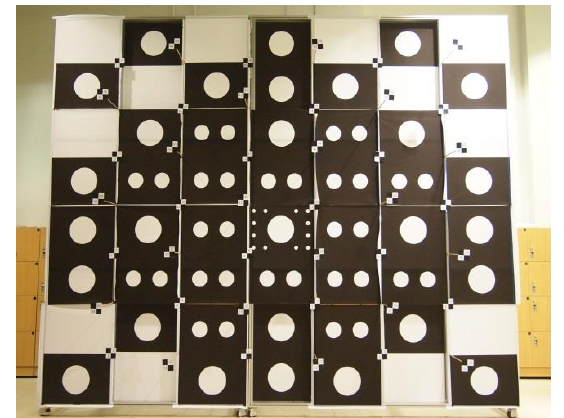
Figure 9. Testbed for system calibration between optical and range sensor